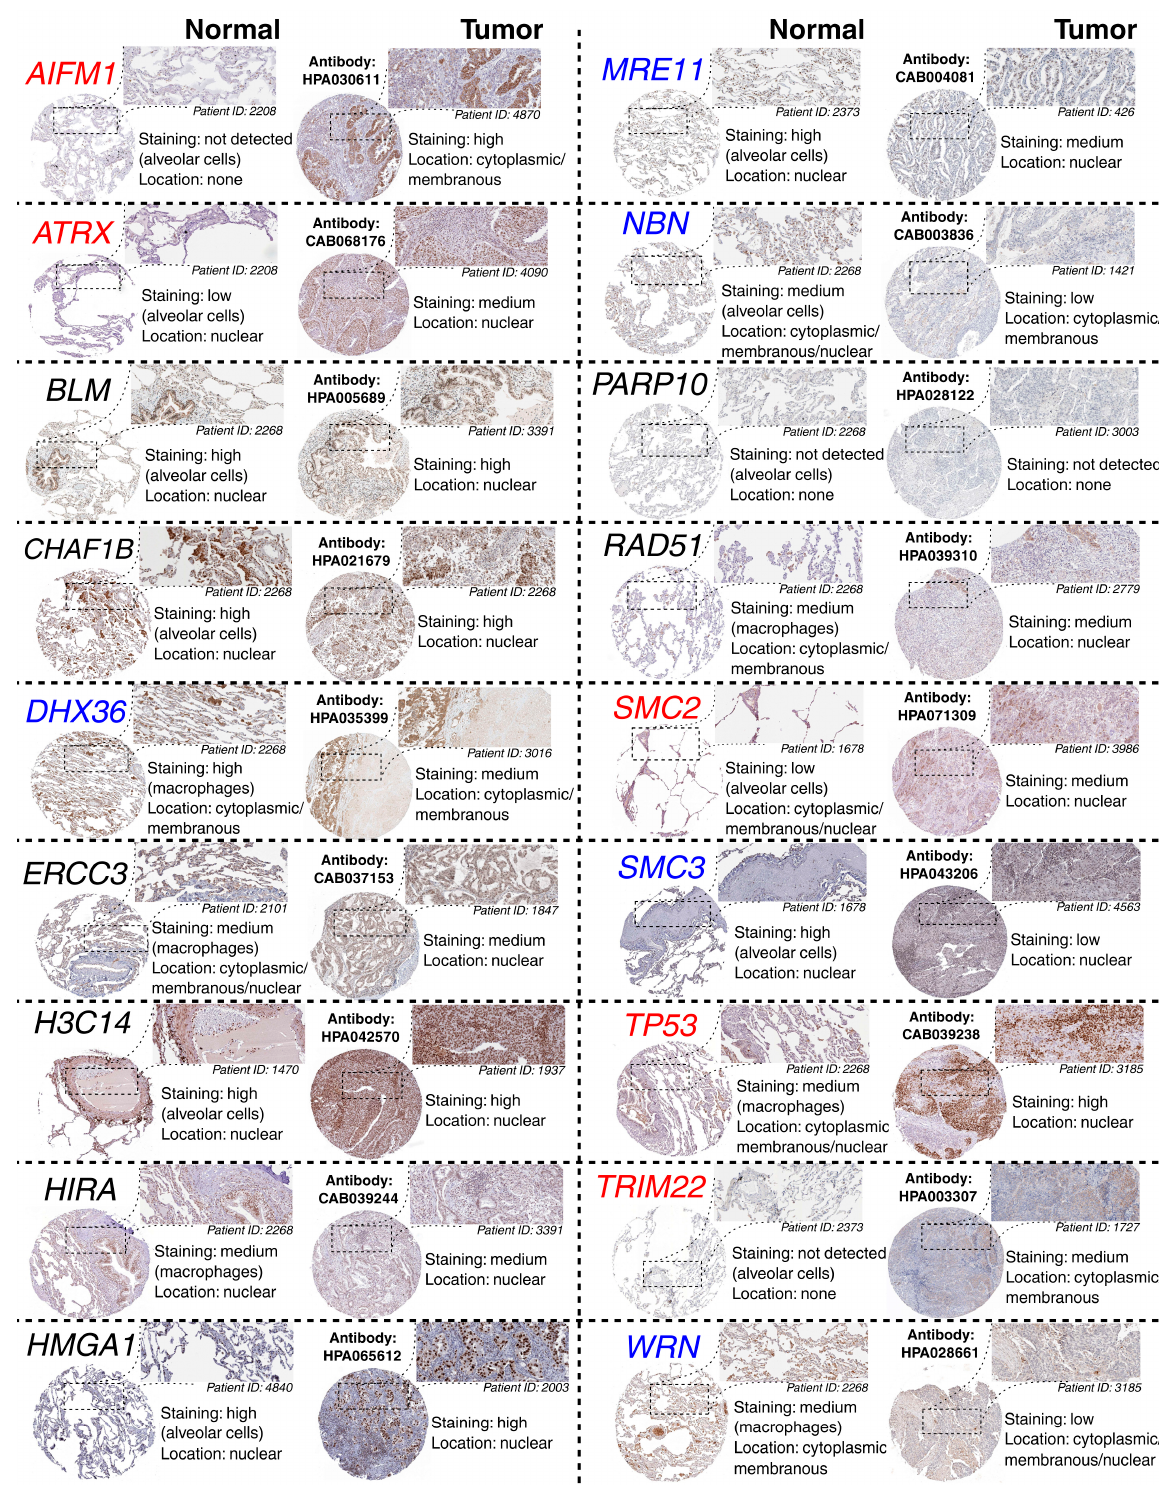
Figure 12. Representative HPA staining data for chromosomal conformation-related genes from normal lung and adenocarcinoma. The genes with various staining in normal vs. tumor comparison are marked in red (if staining is stronger in the tumor) or blue (if staining is weaker in the tumor). One region per specimen is magnified. Antibody catalog number and staining results are provided.